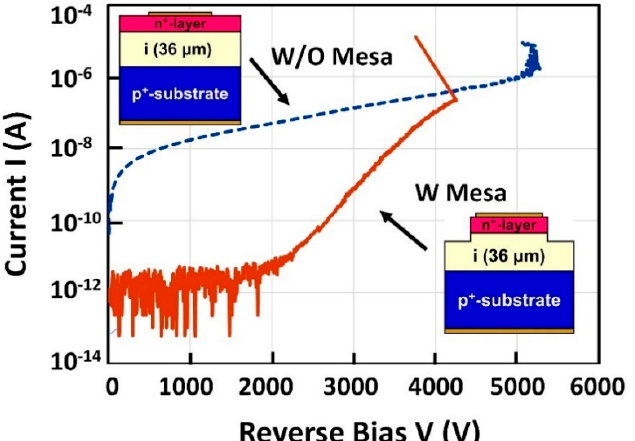
Figure 8. A representative reverse I–V property for diamond PiN diode (drift layer thickness 70 µm).